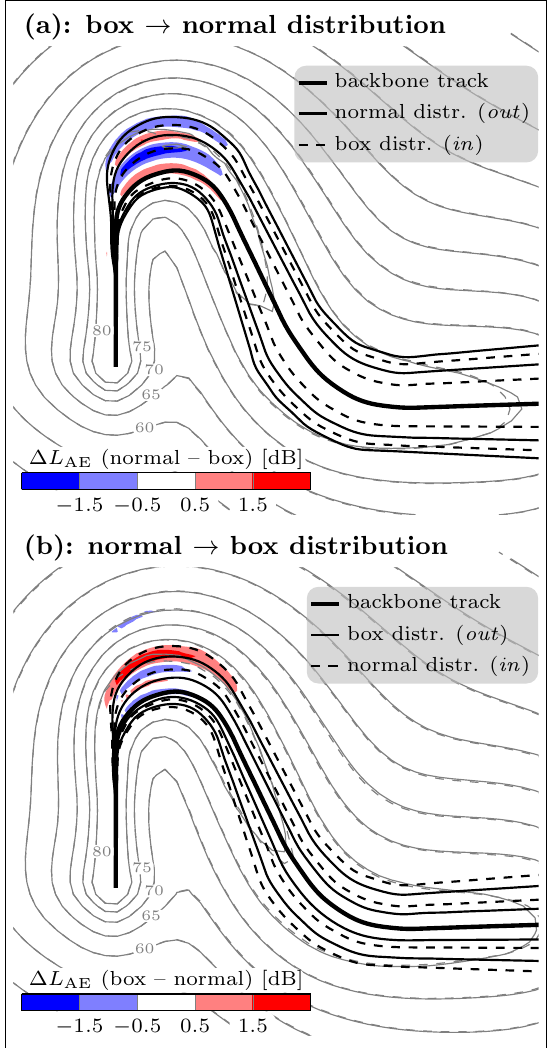
Figure 4: Differences in the resulting L AE on the receiver grid be- tween the calculation using 5 and 3 subtracks, with normal dis- tributions in all cases, using (a) the method presented in [4], and (b) the method presented in this paper, assuming the movement percentages from Table 1, for an A320